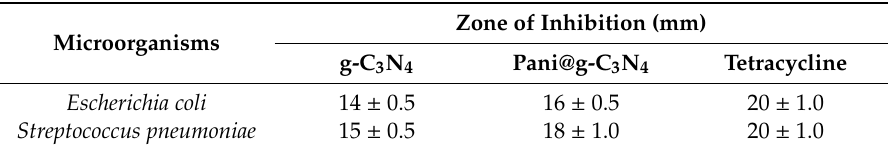
Table 1. Zone of inhibition in the presence of the